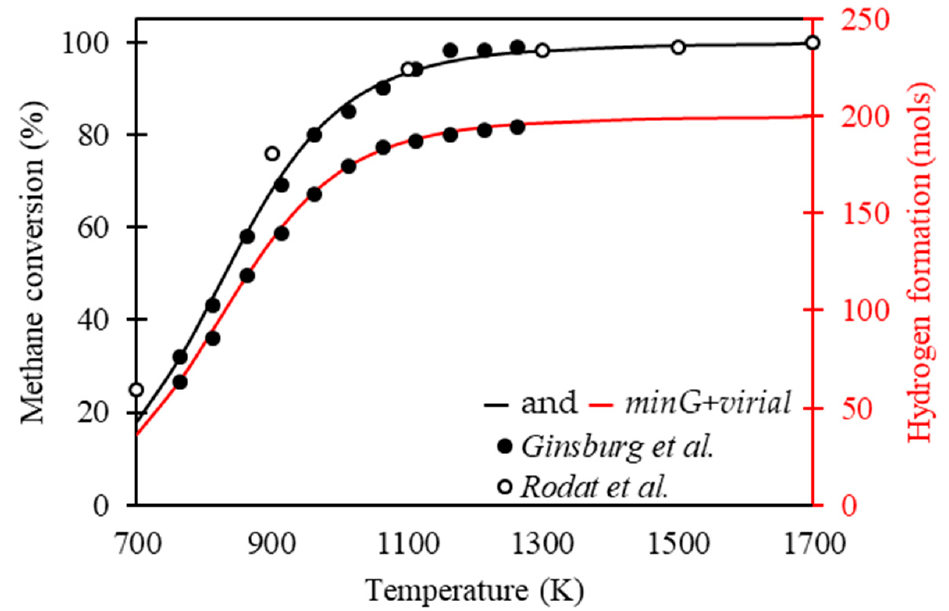
Figure 5. Conversion of methane and formation of hydrogen in the equilibrium condition as a function of 1 atm temperature with 100 moles of methane in the feed.